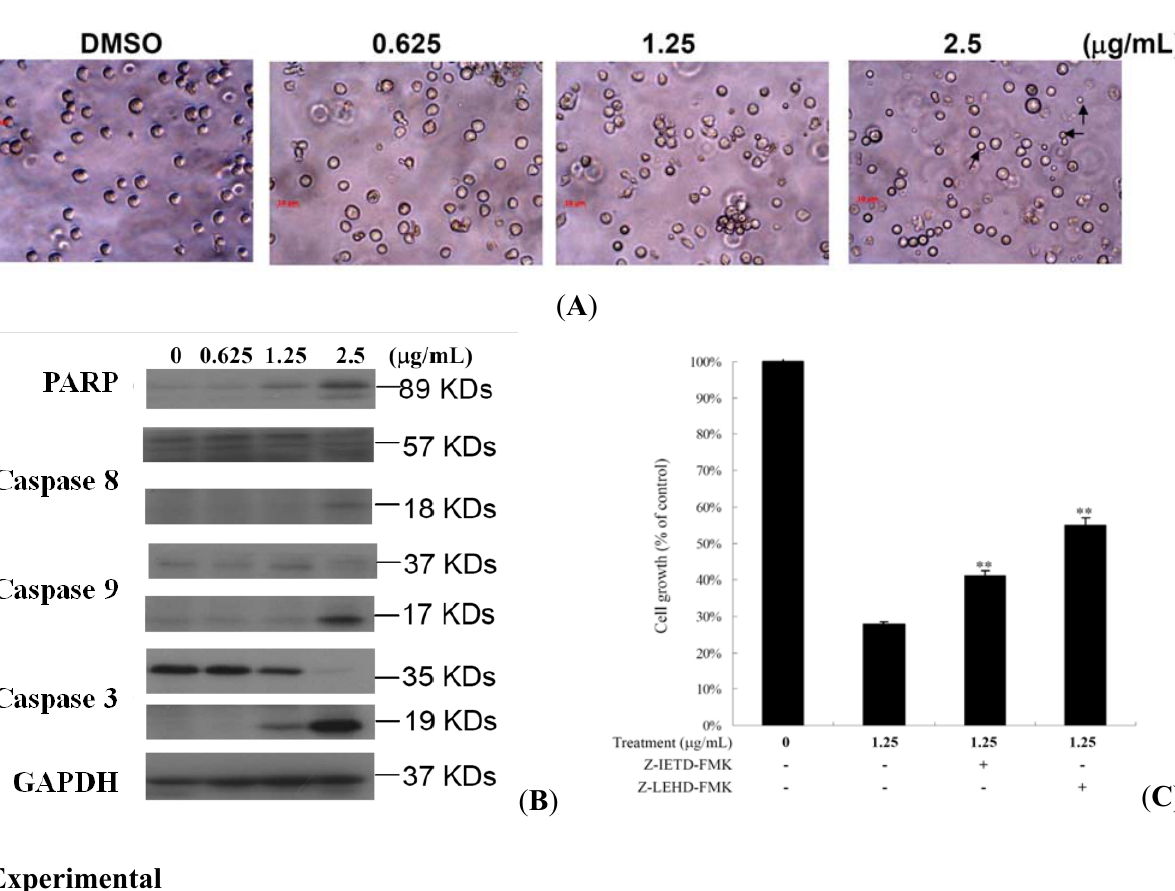
Figure 4. Apoptotic effect induced by 10-acetylirciformonin B in HL 60 cells. ( A ) Cells were treated with 0.625, 1.25 and 2.5 g/mL of 10-acetylirciformonin B for 24 h, and photographed under microscope (400×). The arrowheads point at the apoptotic bodies; ( B ) Western blotting analysis of apoptosis-related proteins expression in HL 60 cells after 10-acetylirciformonin B treatment at different concentrations for 24 h. GAPDH was used as an internal control to show the equal loading of protein; ( C ) HL 60 cells were preincubated with 25 nM caspase 8 or 9 inhibitors (z-DEVD-fmk or z-IETD-fmk) for 2 h, followed by 10-acetylirciformonin B treatment for 24 h. Cell viability was evaluated by MTT assay. Untreated cells were used as a